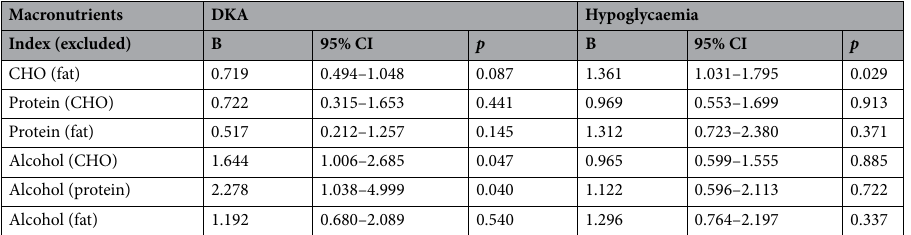
Table 4. Associations between macronutrient substitutions and acute hospitalisations due to ketoacidosis and hypoglycaemia. Logistic regression analysis. For DKA, the models are adjusted for age, sex, insulin dosing per weight in kg, physical activity, HbA 1c , and diastolic blood pressure; for hypoglycaemia, the adjustments were made for age, sex, insulin dosing, physical activity, smoking, total cholesterol concentration, and estimated glomerular filtration rate. In these substitution models, one of the macronutrients (shown in the parentheses) is left out, while one of the macronutrients is the index macronutrient. The beta value represents an increase or decrease in the risk of diabetic ketoacidosis or hypoglycaemia hospitalisation when the intake of the index macronutrient is increased by 5% at the expense of the excluded macronutrient. DKA diabetic ketoacidosis, CHO